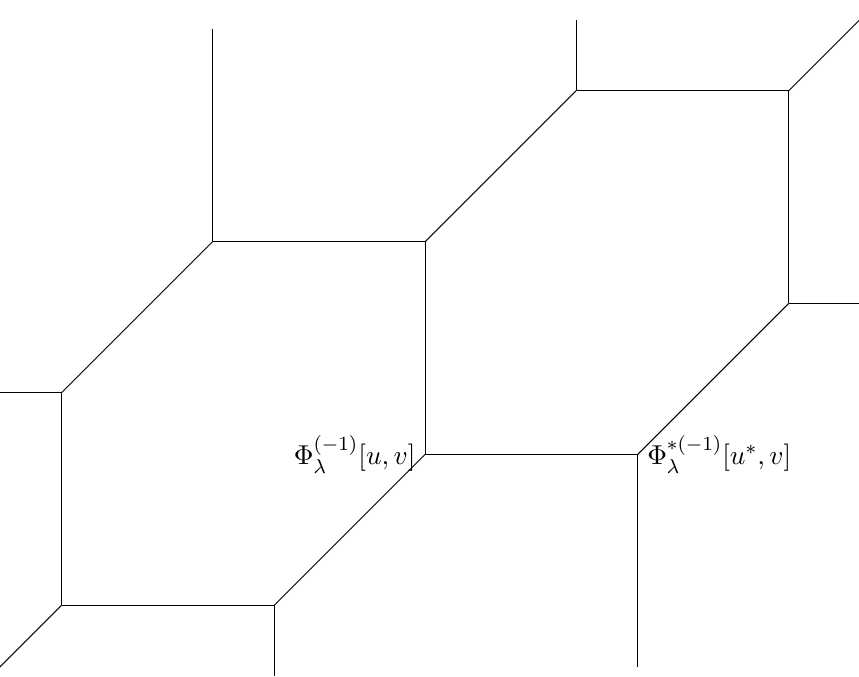
Figure 3 . A typical representation web (toric diagram) for